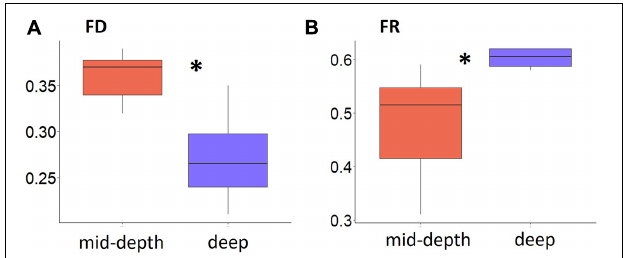
FIGURE 5 | Boxplot of functional diversity indices for epifauna from the Chukchi Borderland, (A) Functional Diversity (FD) (represented by Rao’s Q) and (B) Functional Redundancy (FR) for mid-depth and deep ROV samples. Asterisks indicate significant differences between mid-depth (red) and deep (blue) stations ( p < 0.05, Kruskal–Wallis test). Note the scales of the y -axes are different.